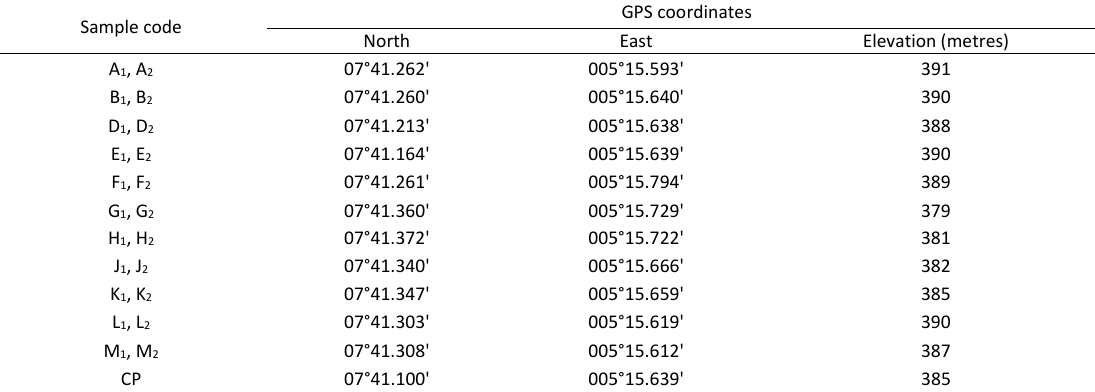
Table 1: Global Positioning System location of sampling points